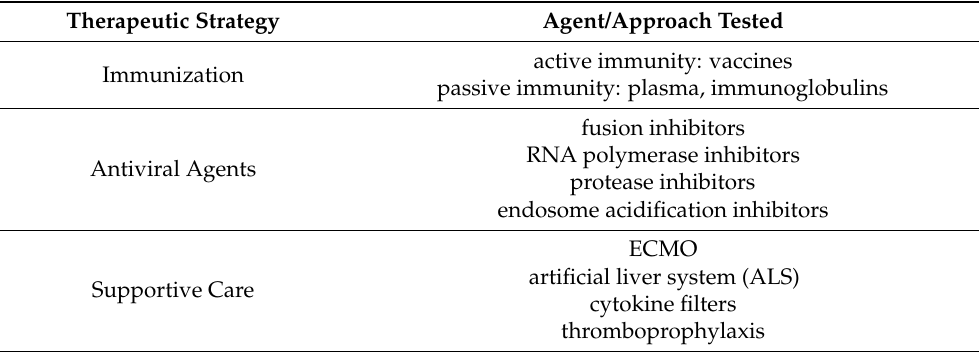
Table 1. Therapeutic modalities against COVID-19